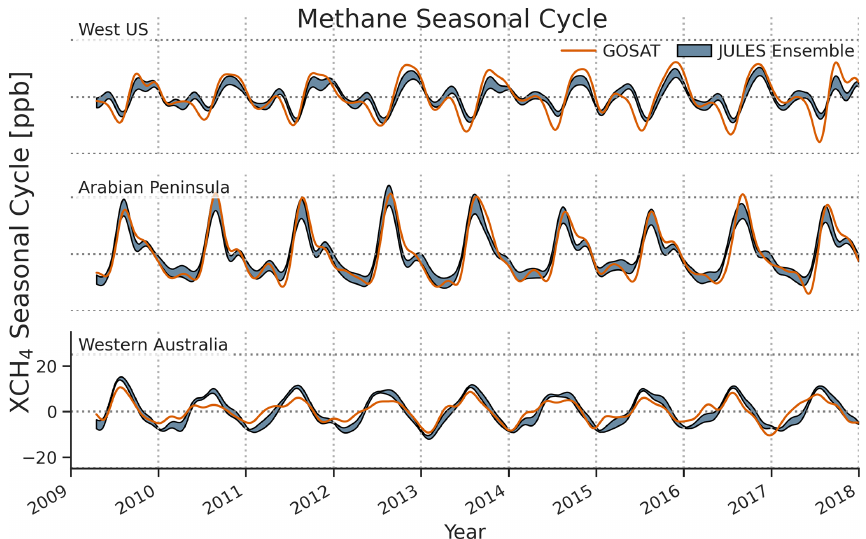
Figure B2. Time series showing the methane seasonal cycle as determined from GOSAT (orange) and the JULES ensemble (blue) over the three non-wetland regions indicated (red) in Fig.